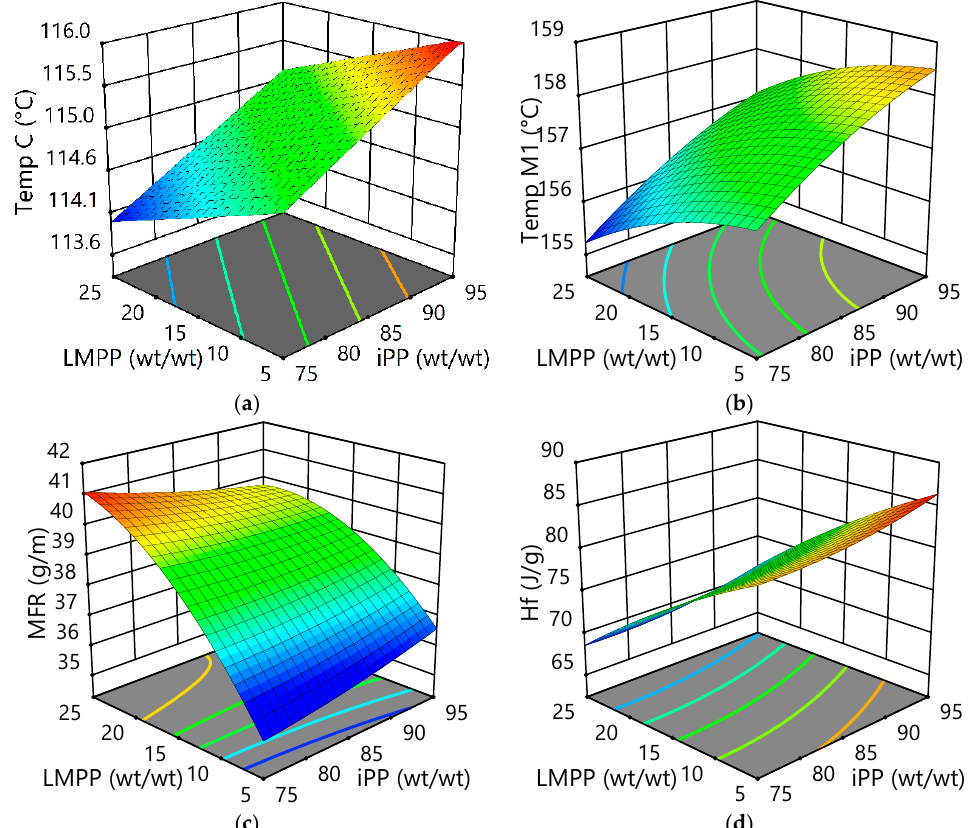
Figure 4. 3D surface plots for the effects of LMPP on iPP/LMPP blend fibres for ( a ) crystallization temperature ( T C ), ( b ) first melting temperature ( T M1 ), ( c ) melt flow rate (MFR) and ( d ) heat fusion ( Hf ).